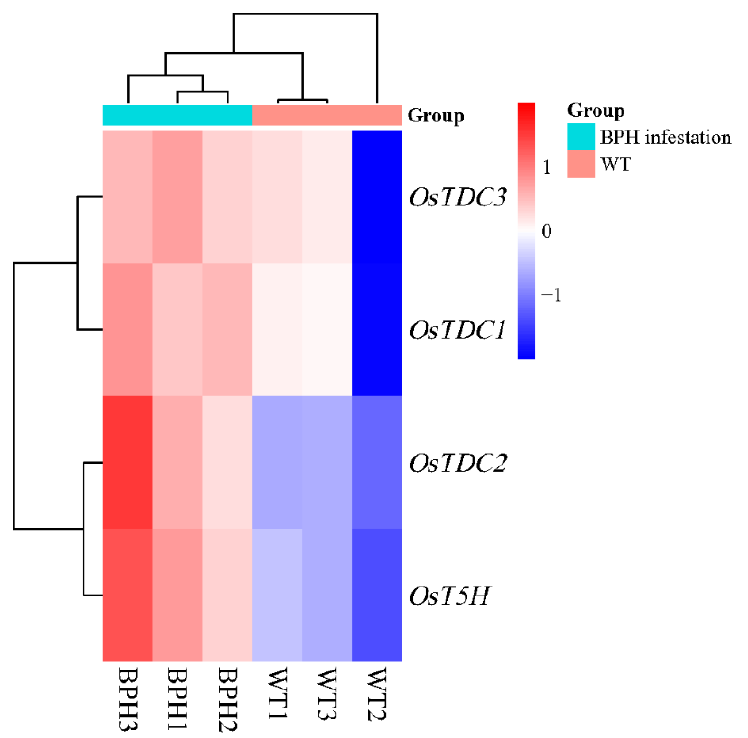
Figure 2. Heatmap indicates the expression profiles of four key genes involved in serotonin biosyn- thesis induced by BPH nymph infestation for 12 h. The colors illustrate the expression levels of each gene based on values of log 2 FPKM within groups of BPH-infested and non-infested (WT) rice plants. Red, upregulation; blue,